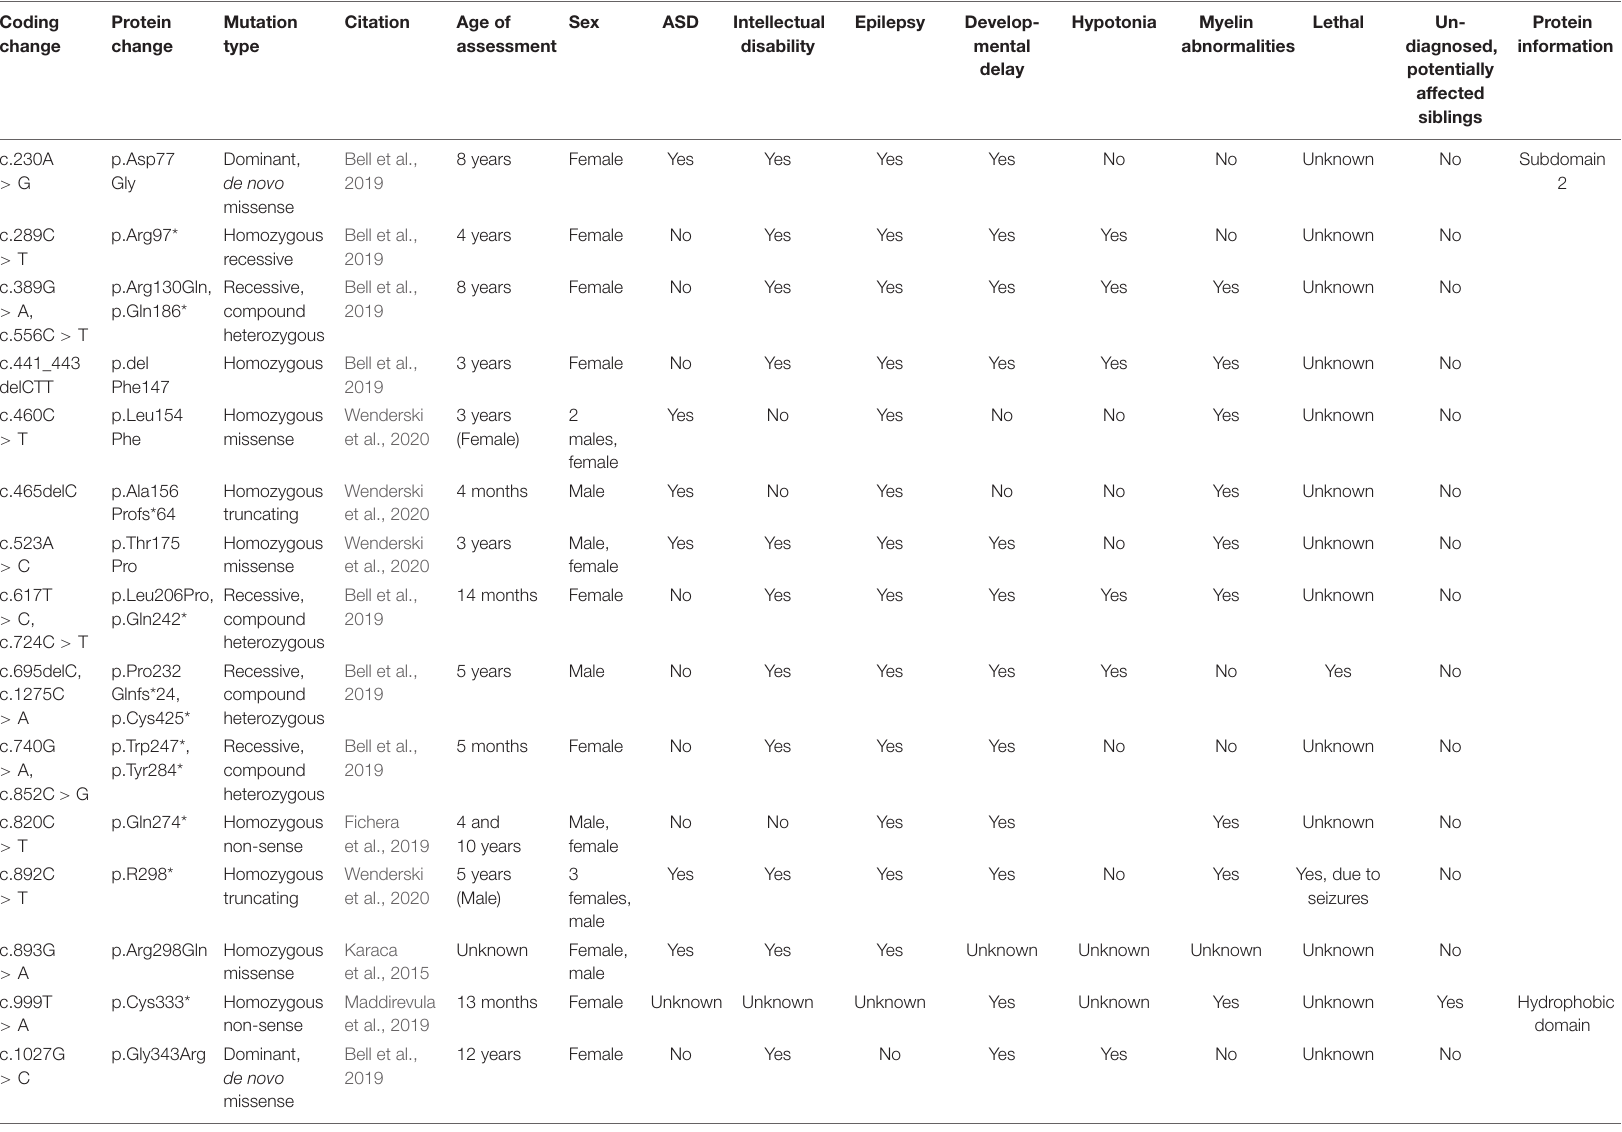
TABLE 1 | Summary of Baf53b mutations and patient symptoms. Coding